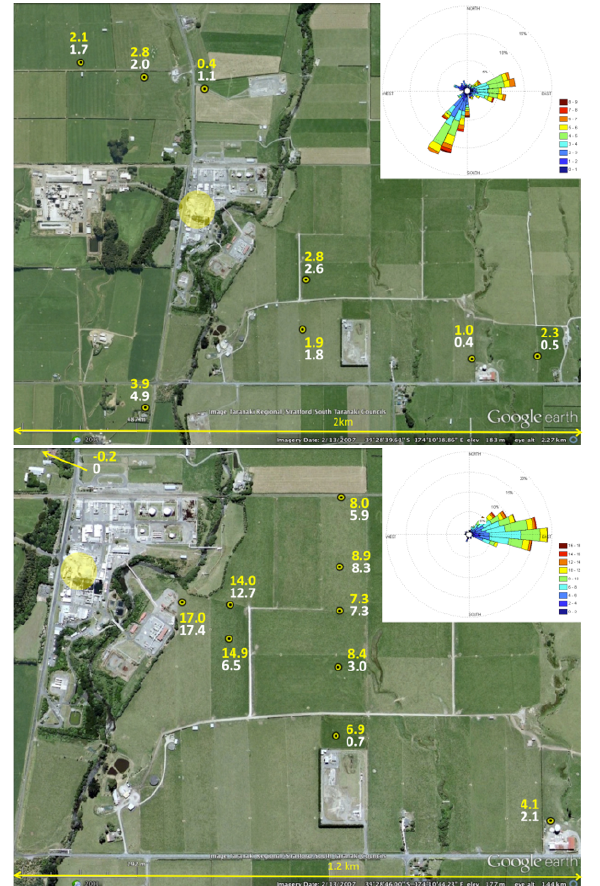
Figure 6. CO 2 ff in grass samples collected on 14 August 2012 (top) and 24 October 2012 (bottom). The observed CO 2 ff derived from 1 14 C is shown in yellow, and the modeled CO 2 ff prediction is shown in white. Markers indicate the exact sampling location. A wind rose showing the direction of the wind patterns over the previ- ous one-week period is inset (bars indicate the direction the wind is traveling to). In the lower panel the point indicated with the arrow was measured 500m to the north-west, off the